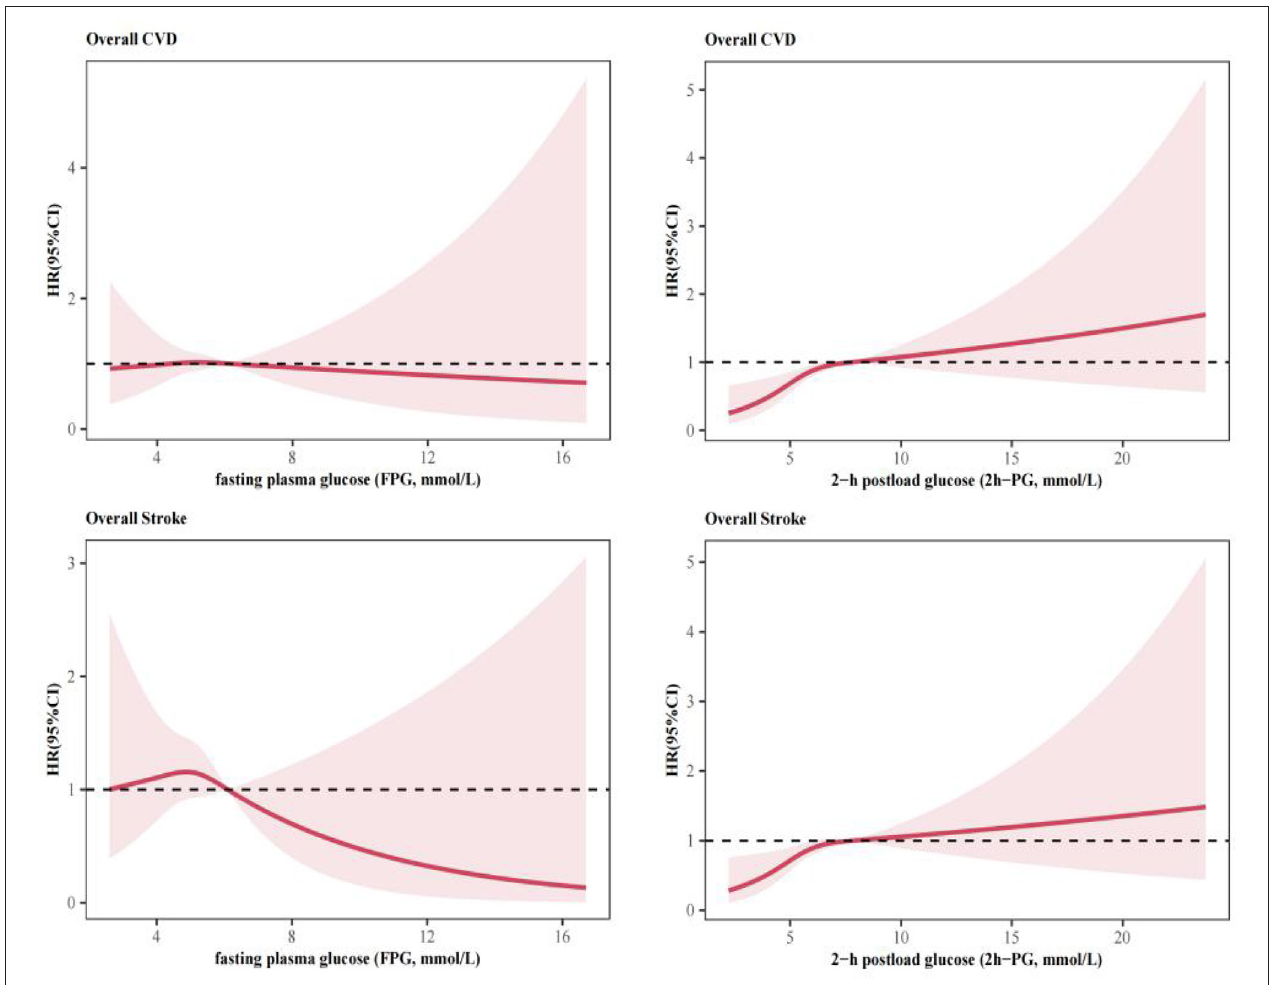
FIGURE 2 | Association of baseline fasting plasma glucose (FPG) or 2-h postload glucose (2h-PG) with cardiovascular diseases (CVD) by using restricted cubic-spline (RCS) plots with three